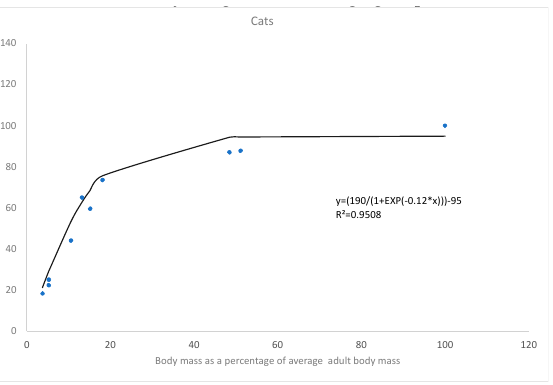
( e ) Brain growth in dogs ( Canis familiaris). Data points represent averages of brain and body weights for each age group (N = 3).